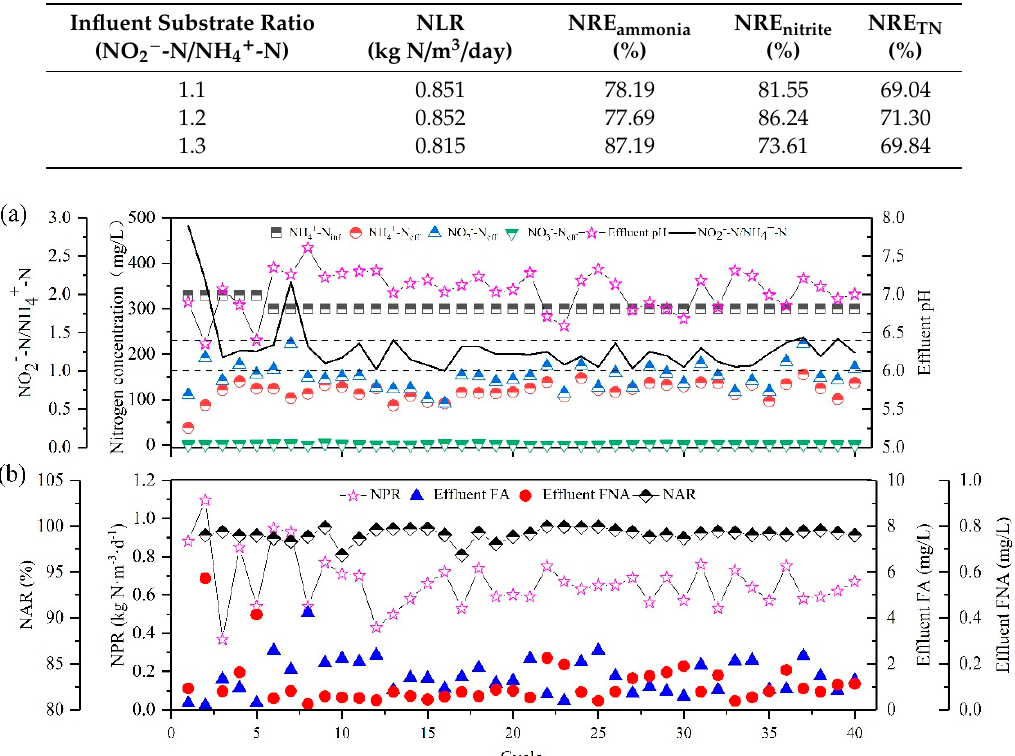
Figure 4. Operational performance of partial nitritation by the zeolite sequencing batch reactor for diluted liquid-ammonia mercerization wastewater in phase III: ( a ) ammonia removal performance, ( b ) variations of nitrite accumulation ratio (NAR), nitrite production rate (NPR), effluent free ammonia (FA) and effluent free nitrous acid (FNA). Table 3. Effects of different influent substrate ratios on the anammox reactor.